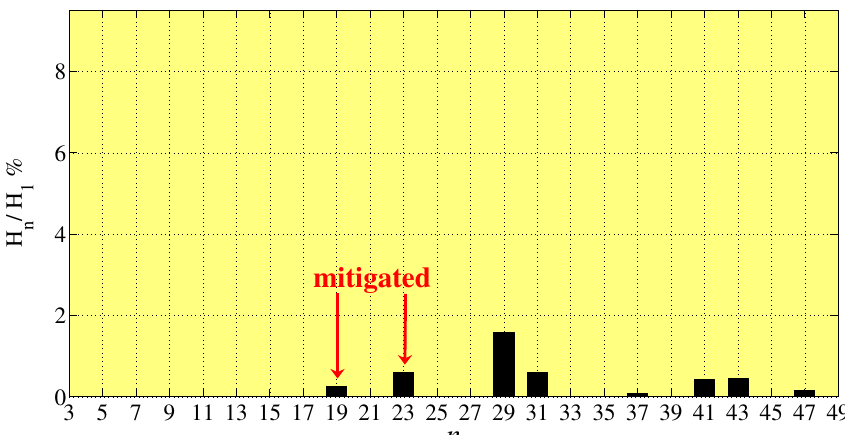
Figure 8. Percentage values of harmonics amplitudes H n with respect to the fundamental H 1 for three-phase 33-level